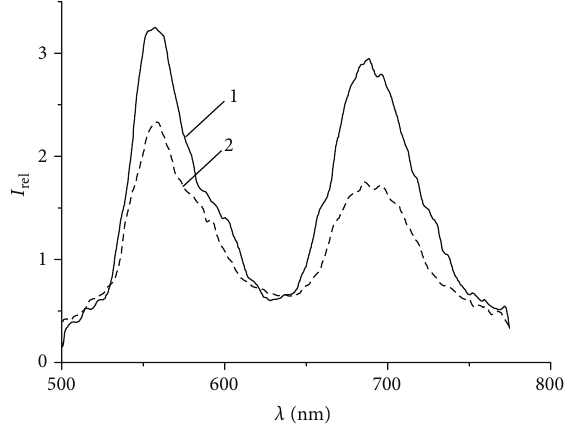
= 4 ⋅ 10 −6 M) in eosin = 1 mg/mL. HSA